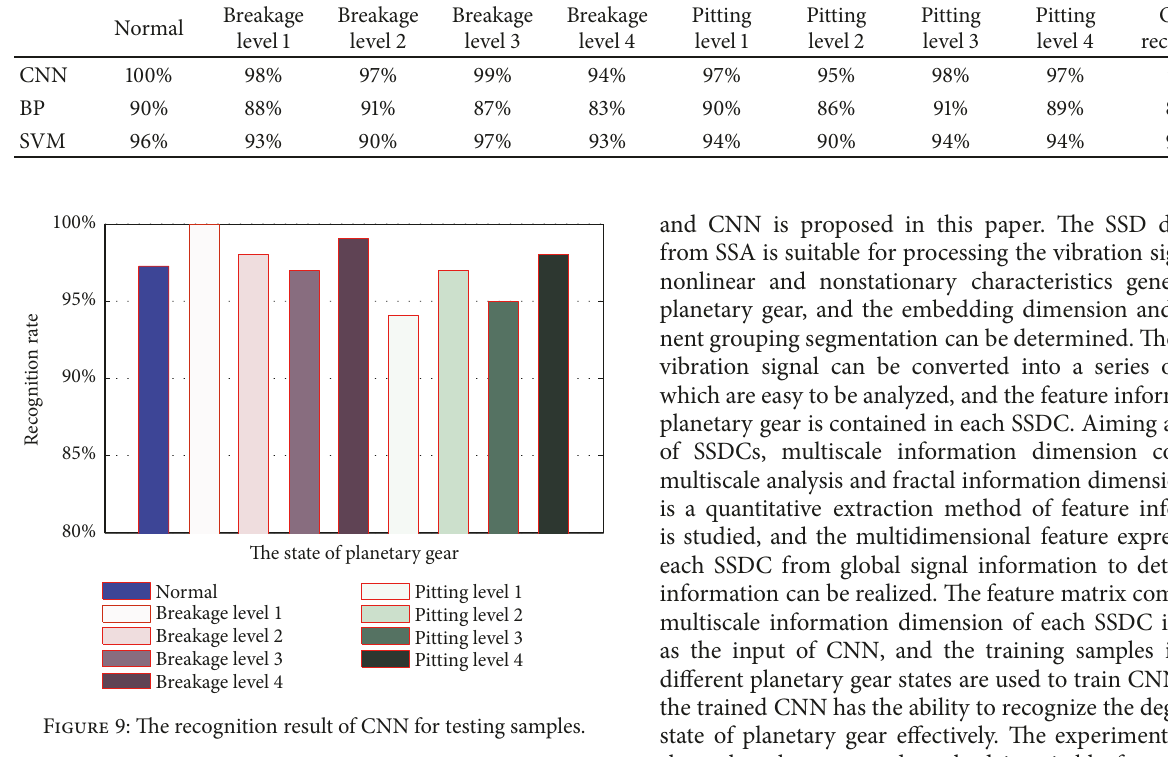
recognition results of CNN, BP neural network, and SVM for testing samples are shown in Table